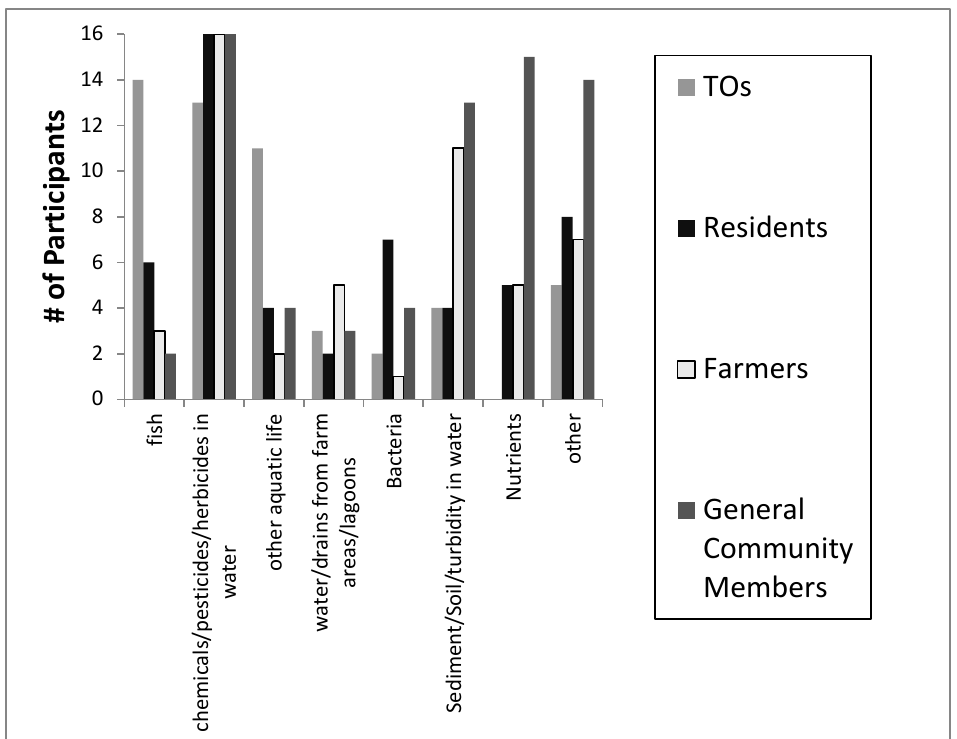
Figure A12. Water quality parameters to be sampled.